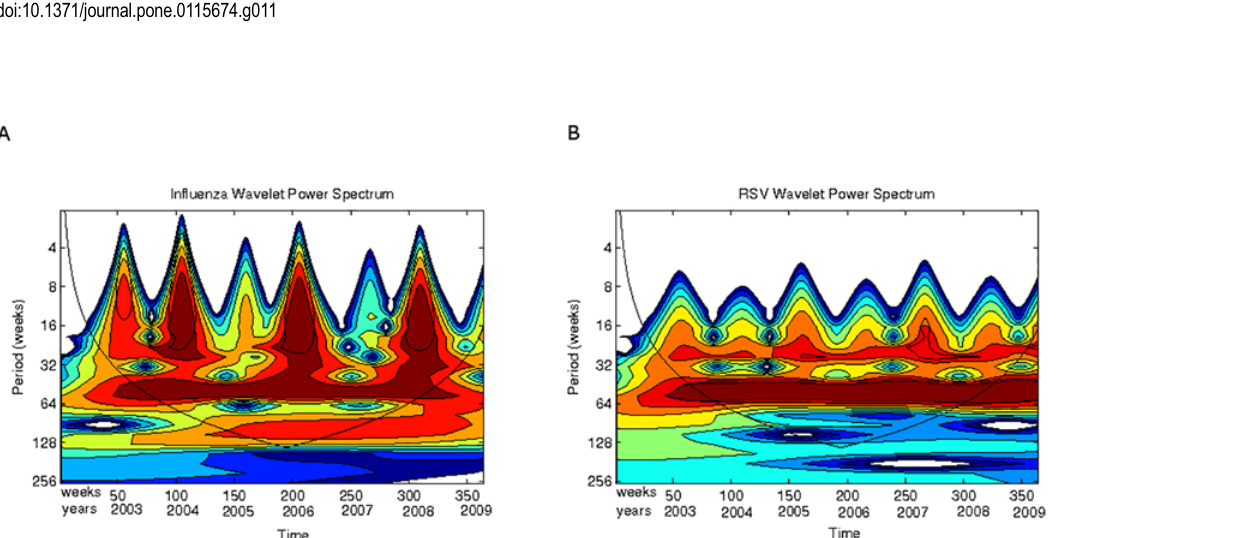
Fig 11. Scalogram (absolute values) for the model simulations for periods up to 64 weeks. (A) Influenza cases. (B) RSV cases. Horizontal axis, weeks numbered consecutively; vertical axis, periods in weeks. See text for explanation.